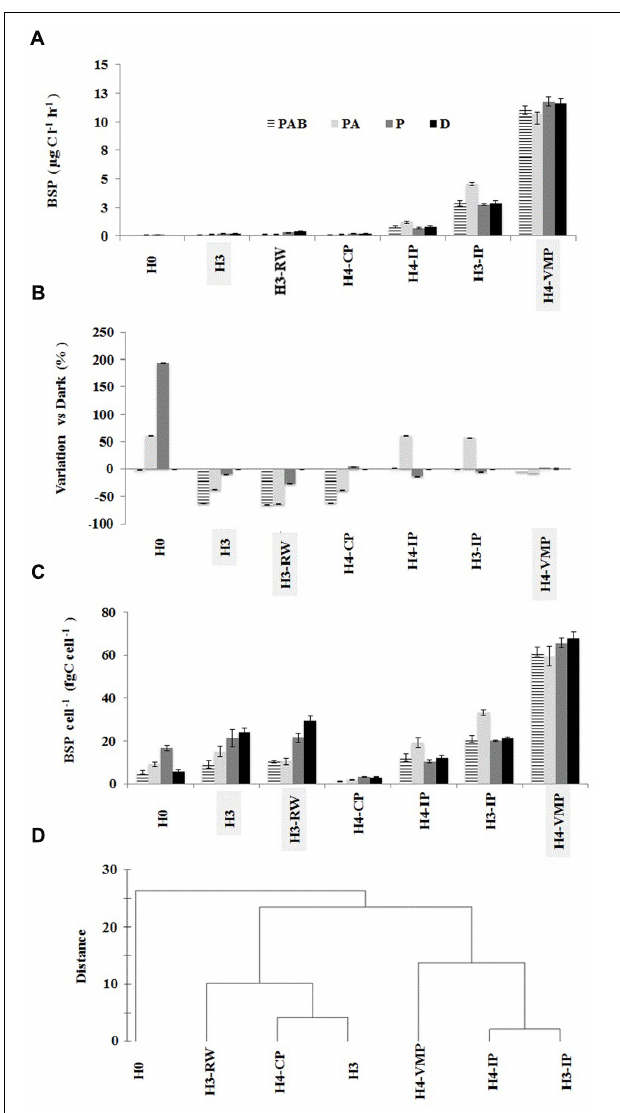
FIGURE 4 | Bacterial secondary production (BSP) experimental response to solar radiation at seven stations in Salar de Huasco. Error bars represent standard deviation. The BSP samples from each sampling site were incubated under four different solar conditions: Full sun (PAB treatment), no UVB (PA treatment), no UV (PAR treatment), and no light exposure (dark treatment). (A) Average BSP under solar radiation treatments expressed as